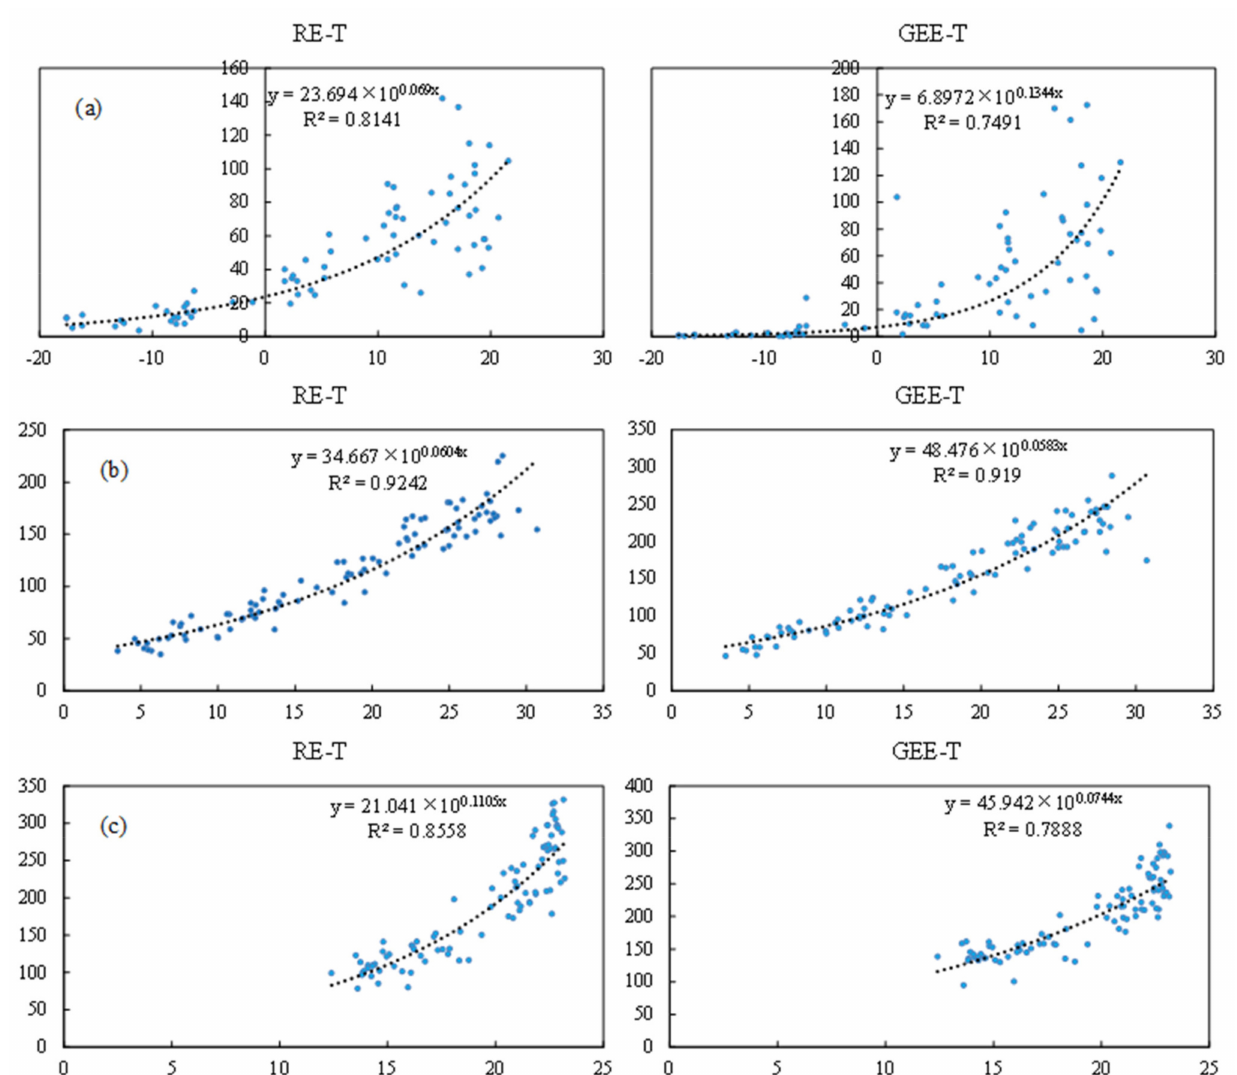
Figure 6. Mathematical modeling of temperature with ecosystem respiration and gross ecosystem exchange in temperate grassland ( a ), subtropical artificial coniferous forest ( b ), and tropical rain forest ( c ). Note: RE is ecosystem respiration, GEE is gross ecosystem